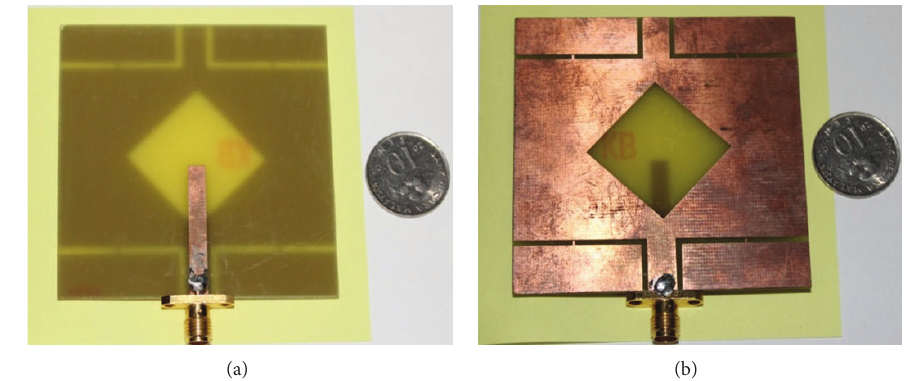
Figure 14: Fabricated prototype: (a) front view, (b) back view.